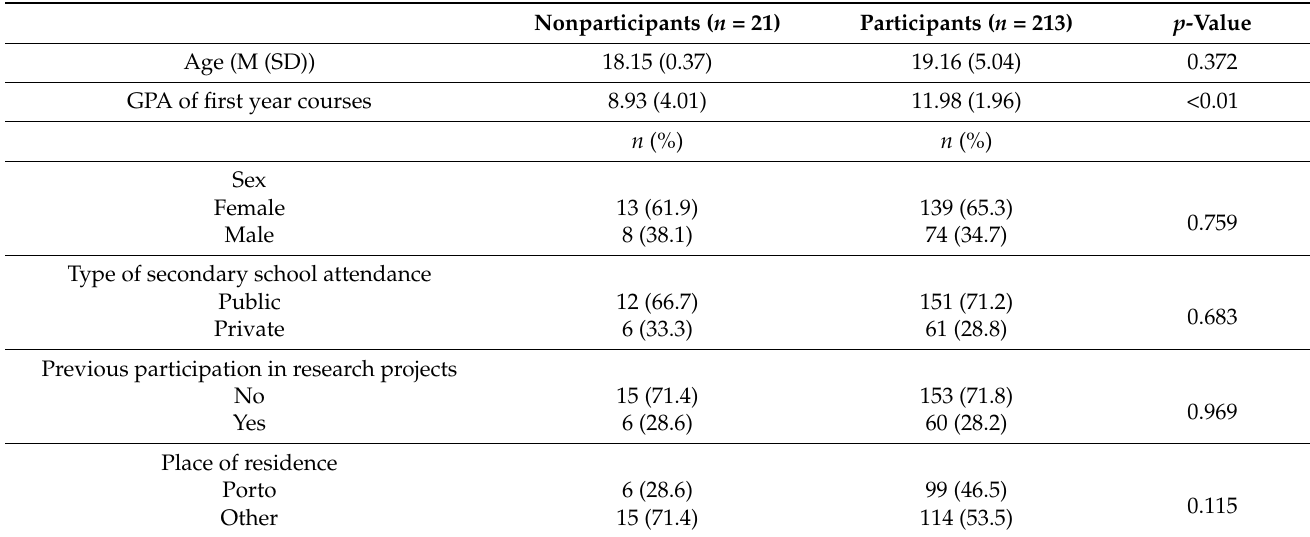
Table 1. Comparison of General Information between nonparticipants and participants. Nonparticipants ( n = 21) Participants ( n = 213) p -Value 18.15